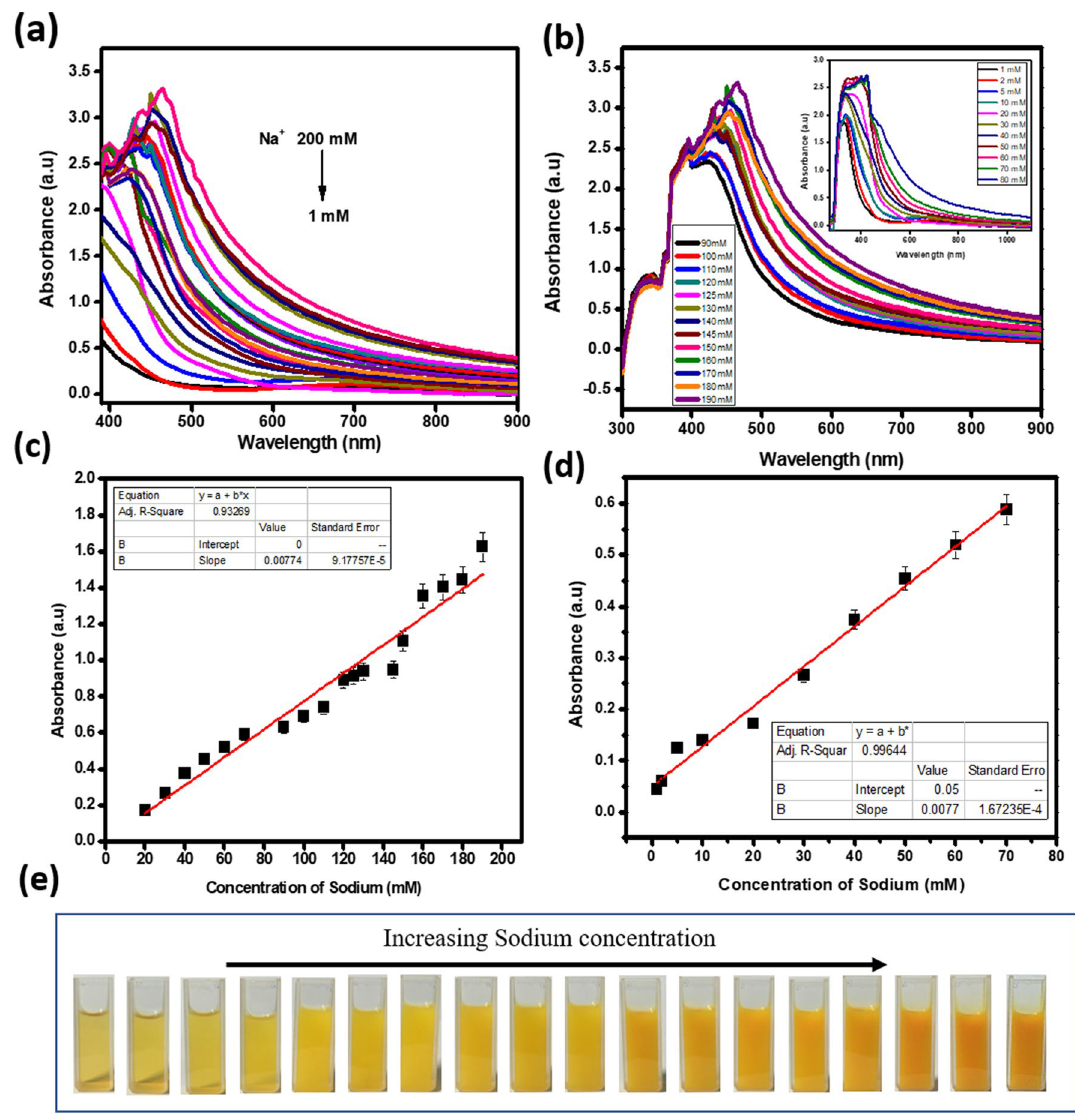
Figure 6. ( a ) Absorbance profile of CuC upon the addition of Na + . ( b ) Concentration of Na + from 90 to 190 mM. Inset figure- concentration of Na + from 1 to 80 mM. ( c ) and ( d ) Linear responses of absorbance changes at 557 nm with respect to the concentration of Na + . ( e ) Photograph of CuC with different concentrations of Na + . Error bars represent standard error of the mean (n =